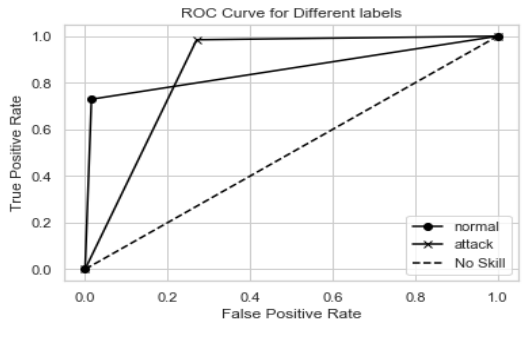
Fig 8. (a) and (b) are the ROC curves of normal and attack classes for random forest classifier and Extra tree classifier respectively. (c) and (d) are the ROC curves of normal and attack classes for AdaBoost and XGBoost classifiers